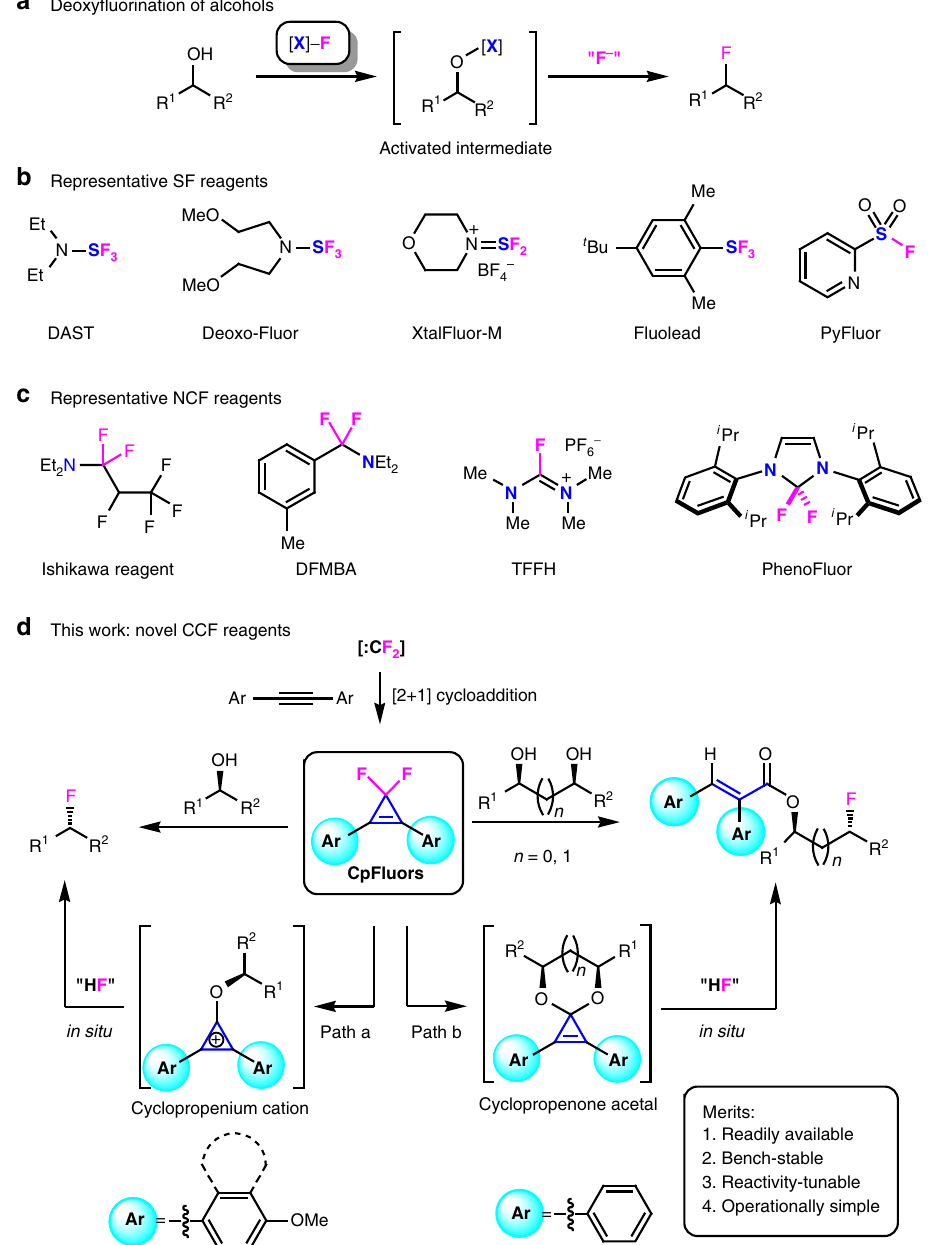
Figure 1 | Methods for deoxyfluorination of alcohols. ( a ) General route for deoxyfluorination of alcohols, proceeding through the activation of alcohol followed by displacement with a fluoride ion. ( b ) Representative SF reagents, including aminosulfur trifluorides (such as diethylaminosulfur trifluoride (DAST) and Deoxo-Fluor) 14,15 , aminodifluorosulfinium salts (such as XtalFluor-M) 16 , arylsulfur trifluorides (such as Fluolead) 17 and sulfonyl fluorides (such as PyFluor) 18 . ( c ) Representative NCF reagents, including perfluoroolefin-secondary amine adducts (such as Ishikawa reagent) 19 , difluorobenzylamines (such as N , N -diethyl- a , a -difluoro-( m -methylbenzyl)amine (DFMBA)) 20 , fluoroiminium salts (such as tetramethylfluoroformamidinium hexafluorophosphate (TFFH)) 21 and difluoromethanediamines (such as PhenoFluor) 22 . ( d ) Our method using difluorocarbene-derived CCF reagents, 3,3-difluoro-1,2-diarylcyclopropenes (CpFluors). CpFluors are reactivity-tunable and are capable of fluorinating both monoalcohols (path a) and diols (path b) through different activation